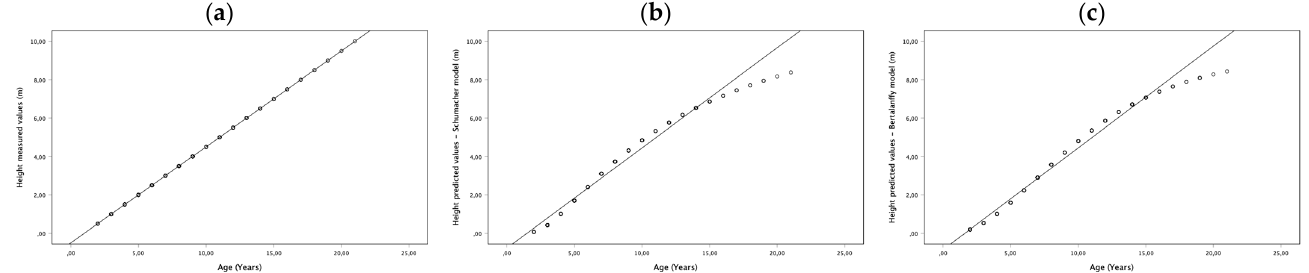
Figure 9. ( a ) Linear model of the projection of height and age determined for the samples used in the study; ( b ) linear model of the predicted height projection determined using the Schumacher model; and ( c ) linear model of the predicted height projection determined using the Bertalanffy model.